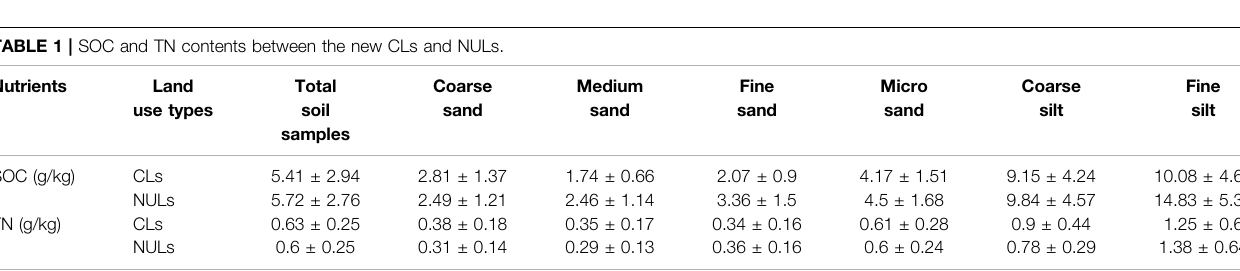
TABLE 1 | SOC and TN contents between the new CLs and NULs.